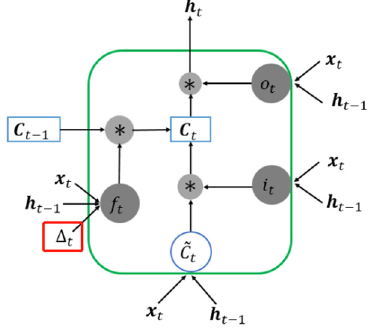
Figure 3. Improved LSTM